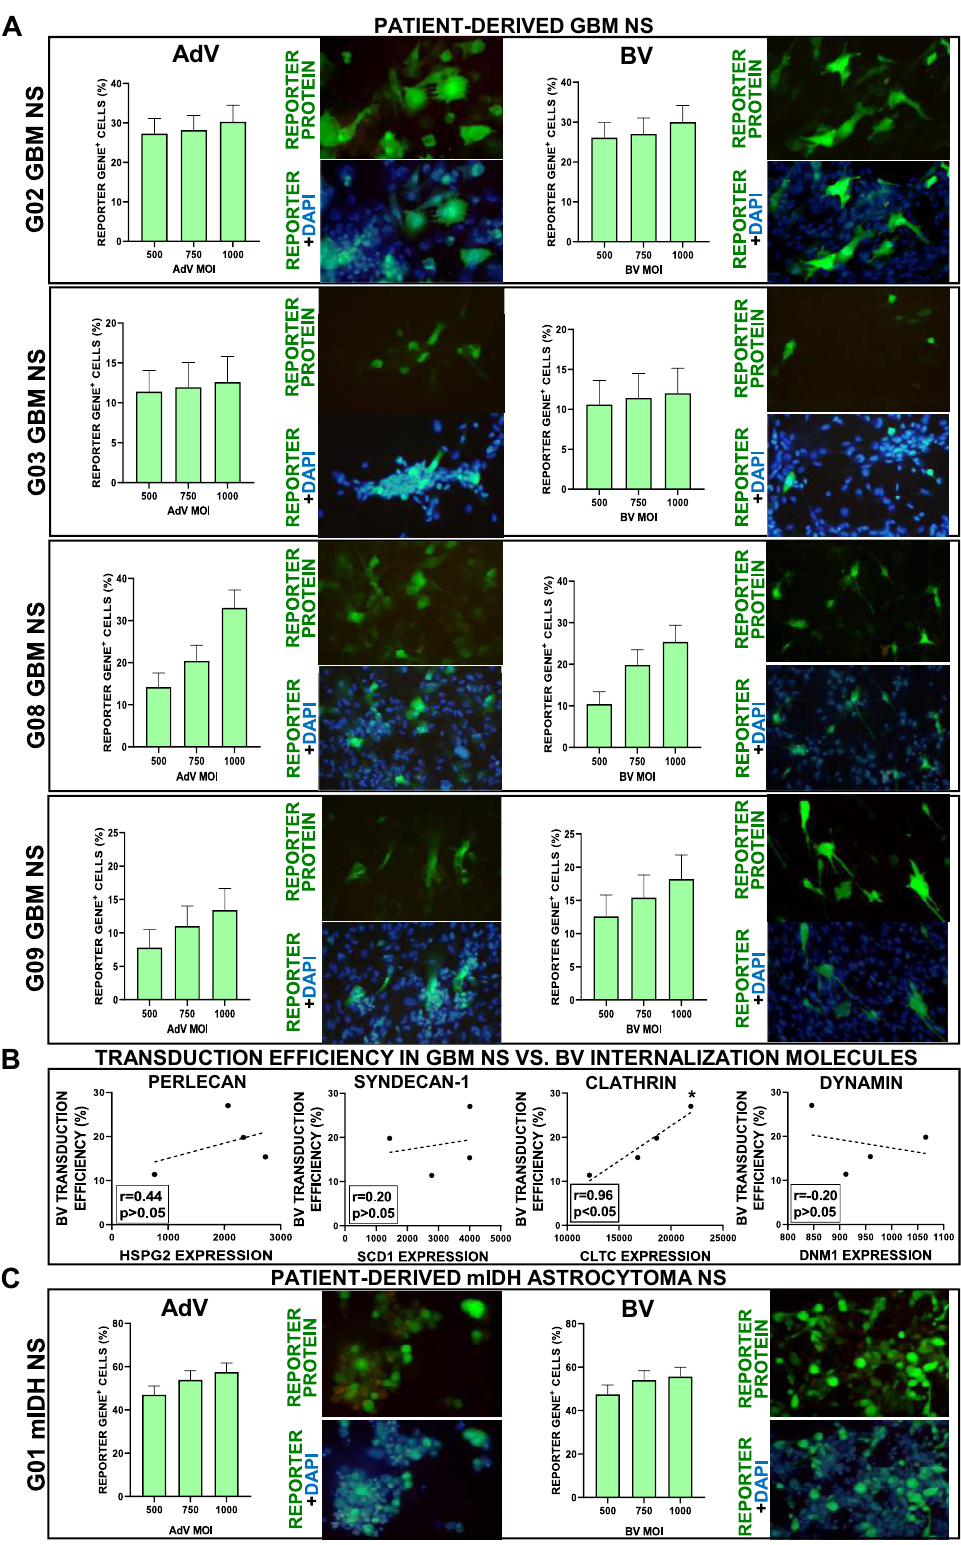
FIG. 2. TRANSDUCTION EFFICIENCY OF AdV AND BV IN PATIENT-DERIVED GBM AND mIDH ASTROCYTOMA NEUROSPHERES